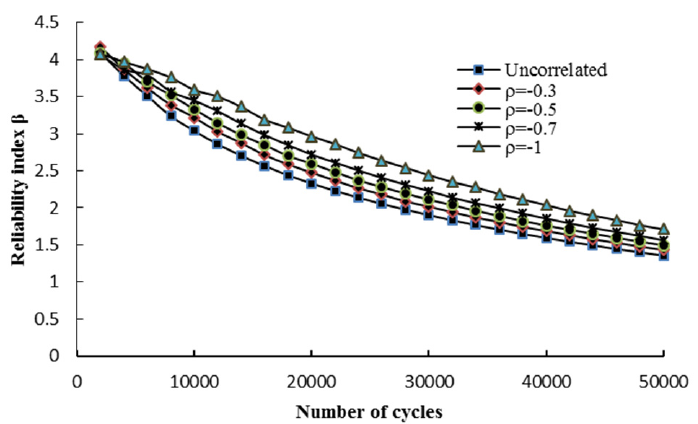
Figure 10. Impact of correlation between material parameters on reliability level of submarine pipeline.